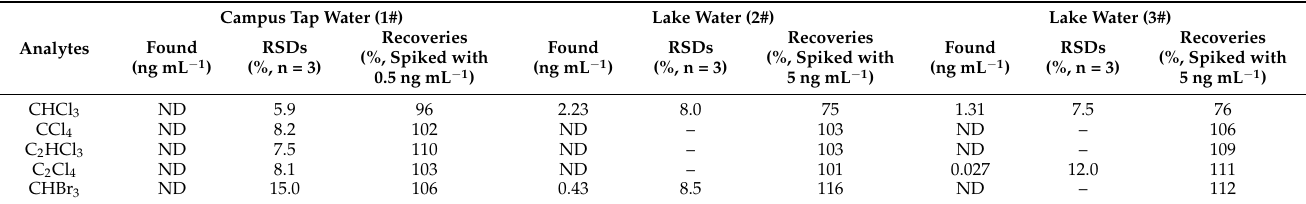
Table 2. Analytical results and recoveries for determination of VHCs from real water